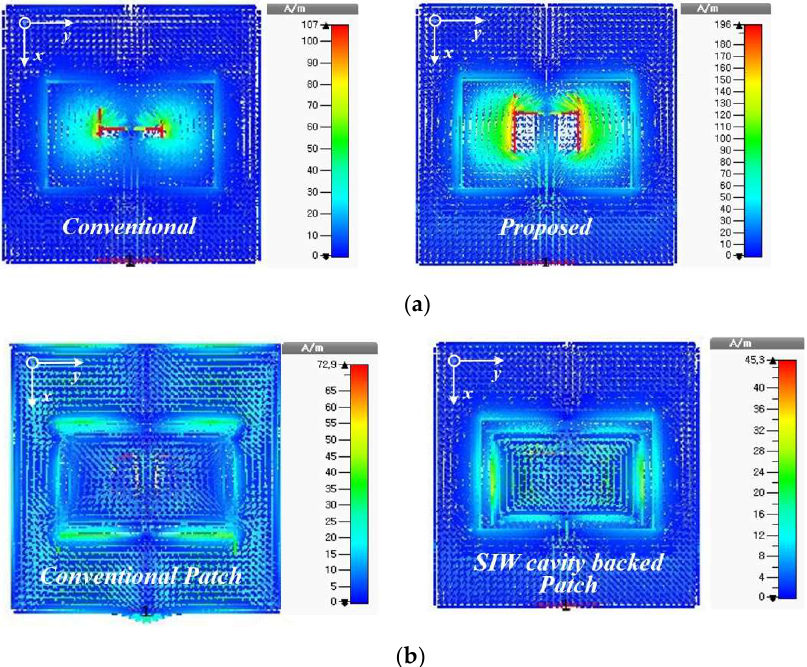
Figure 2. Simulated current distributions on element antenna at 26.2 GHz. ( a ) Conventional versus proposed slot size. ( b ) Conventional versus SIW cavity-backed microstrip patch.